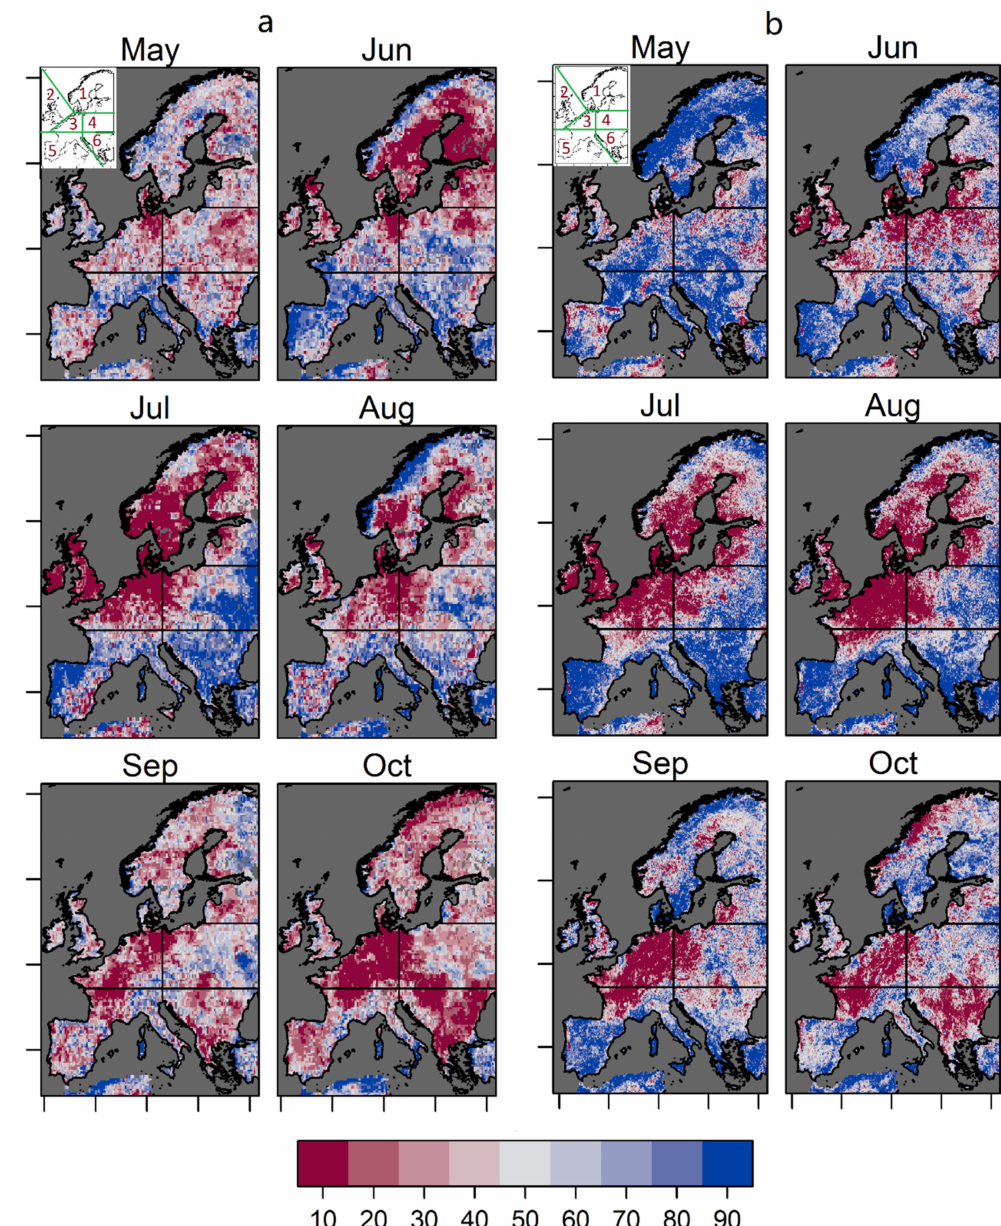
Figure 1. The development of the 2018 drought in Europe from remote sensing data. ( a ) SMC ranking percentiles and ( b ) NDVI ranking percentiles (Equation (1)). The numbers in the upper left corners of ( a , b ) indicate regions that were grouped for similar drought development characteristics. Region 1 (Scandinavia and Baltic), region 2 (British Isles), region 3 (west of Europe), region 4 (east of Europe), region 5 (southwest Europe) and region 6 (Southeast Europe),